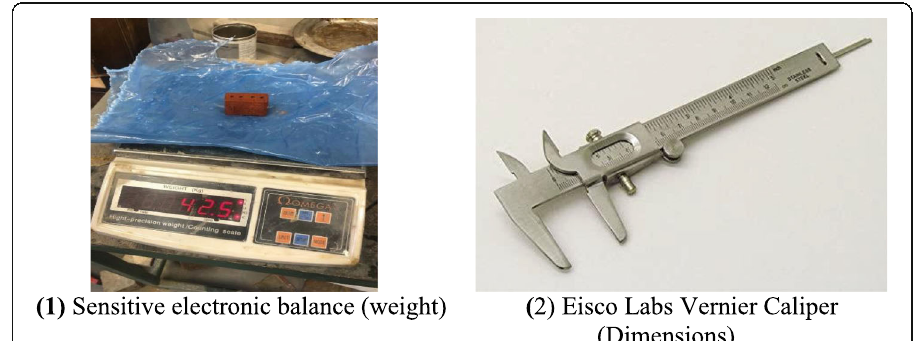
Fig. 7 Weight and dimensions measuring tools. (1) Sensitive electronic balance (weight). (2) Eisco